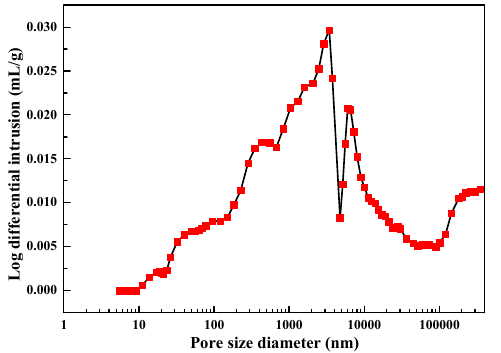
Figure 2. Distribution diagram of the sandstone porosity.